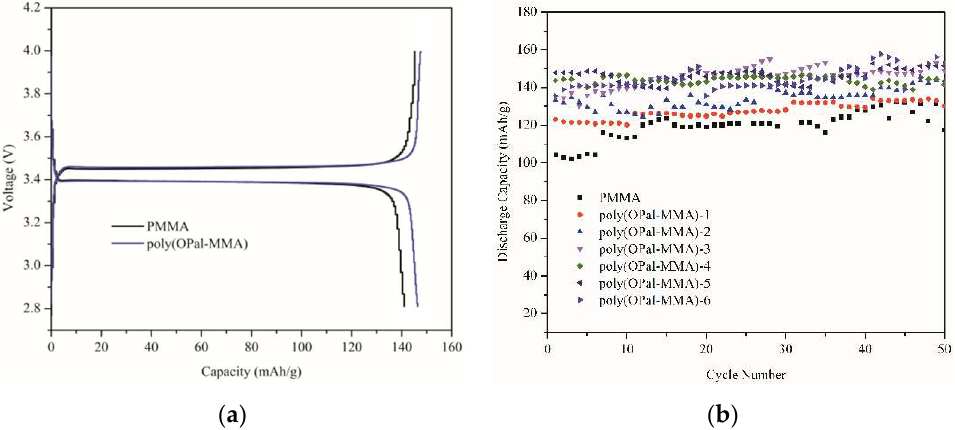
Figure 5. ( a ) Initial charge–discharge curves of the Li/poly(OPal-MMA) electrolyte/LiFePO 4 cell and the Li/PMMA electrolyte/LiFePO 4 cell at 0.1 ◦ C and ( b ) the cycle performance of cells with different polymer electrolytes at 0.5 ◦